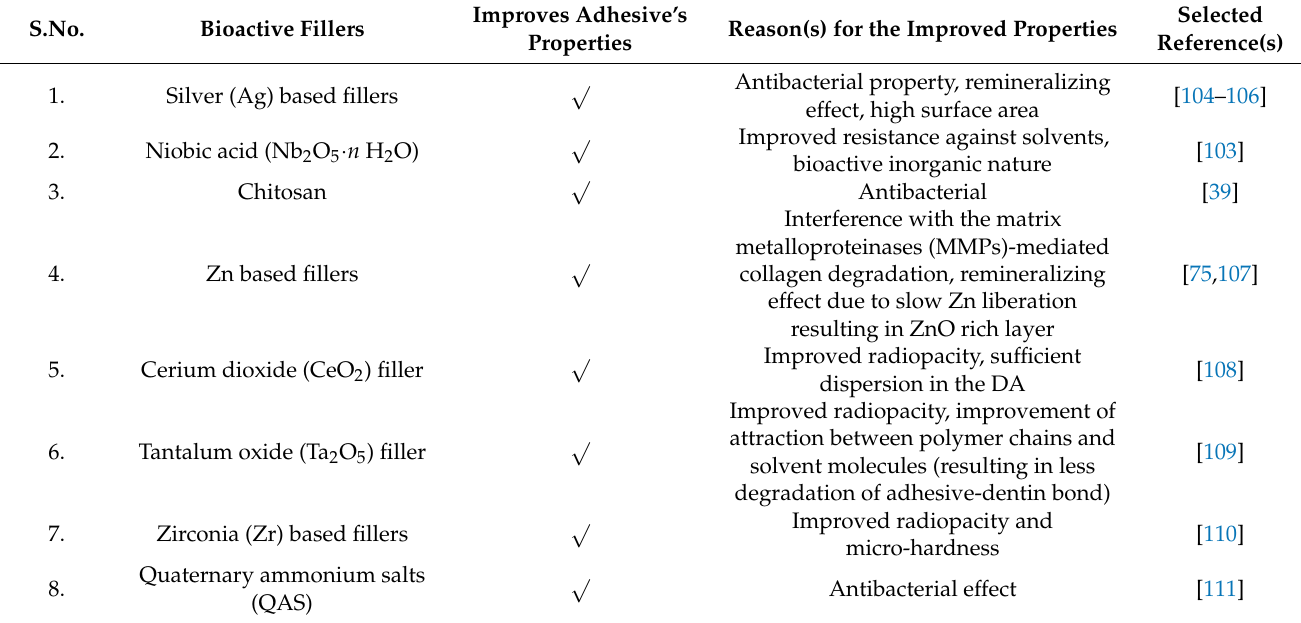
Table 1. Other bioactive inorganic fillers used to enhance properties of DAs mentioned in the literature.